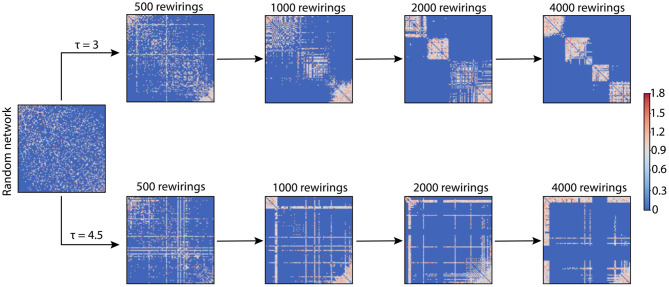
Adjacency matrices for two example networks evolving through adaptive rewiring with different values of τ. The smaller rewiring interval (τ = 3; upper row of adjacency matrices), produces a modular network, i.e., with dense connections within communities and sparse connections between them. The larger rewiring interval (τ = 4.5; lower row of adjacency matrices) has a different effect on the final rewired network; it gives rise to a centralized connectivity structure, where a few nodes have a large number of connections and the rest are sparsely connected or unconnected.